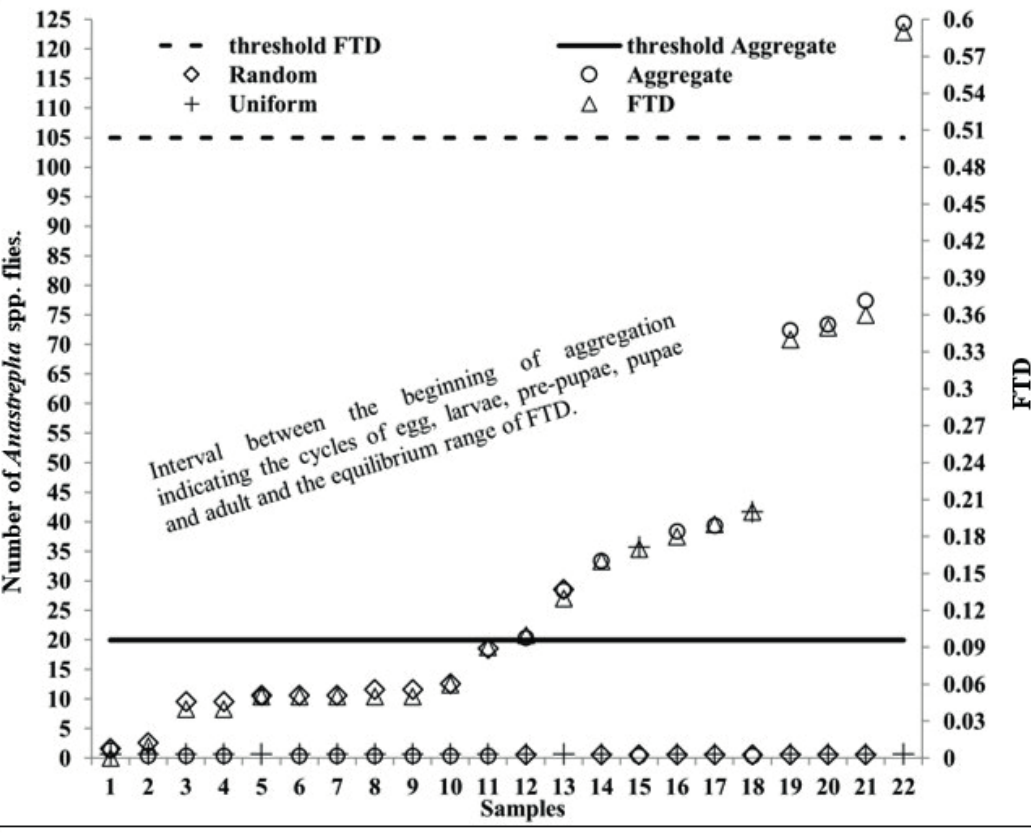
Figure 3 - Range of the negative binomial (NB) thresholds and number of fruit flies per trap/day establishing the levels of population equilibrium and control in three guava orchards (Novo Milênio cultivar) between August 2013 and January 2014 (Ivinhema, State of Mato Grosso do Sul,